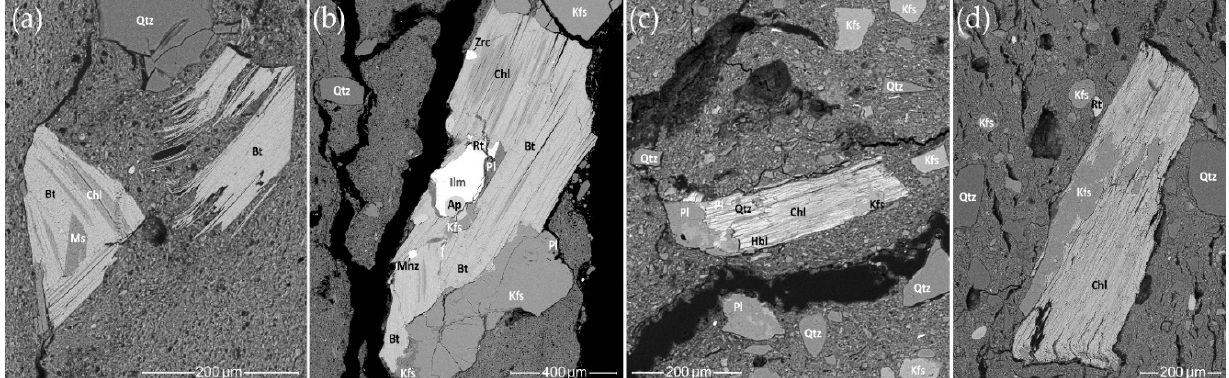
Figure 14. SEM BSE images of micas in the samples: ( a ) HG-L_B3, an alteration of biotite to mus- covite and chlorite; ( b ) HG-L_B4, an altered biotite in a coarse rock fragment; ( c ) HG-E_S3, a weathered hornblende that turned into chlorite; ( d ) CW-L_S2, a coarse fragment of a weathered